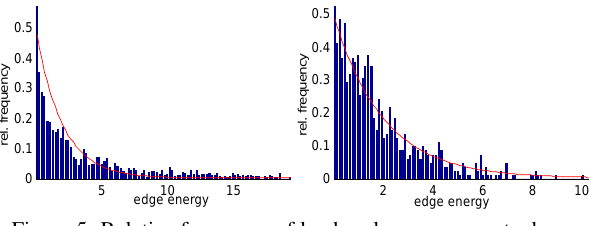
Figure 5. Relative frequency of landmark measurement edge en- ergy at one point in time for the real dataset with the camera fac- ing backwards (left) and for one simulation run (right). The cor- responding χ 2 pdf is drawn in red assuming a stdv. of 0.33